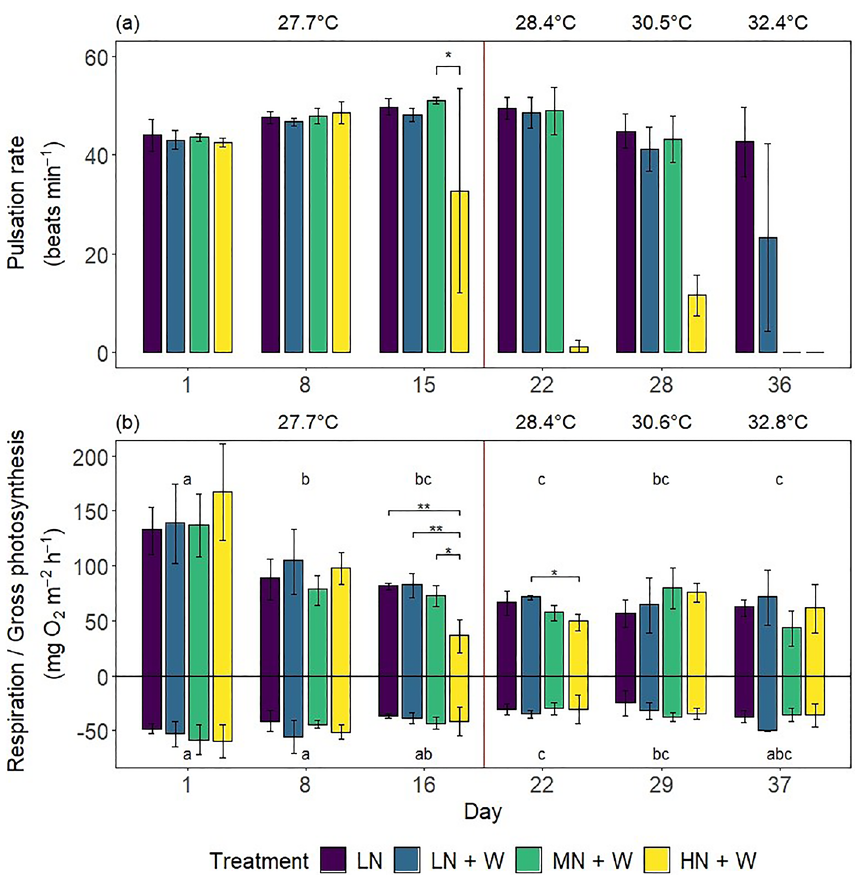
Figure 3. ( a ) Pulsation rates and ( b ) gross photosynthesis (P gross ) and respiration (R) of Xenia umbellata colonies from control tanks with low nitrate (LN, ~ 0.6 μM) and three treatments: LN + W = low nitrate (~ 0.6 μM) + warming from day 17; MN + W = medium nitrate eutrophication (~ 6 μM) + warming from day 17; HN + W = high nitrate eutrophication (~ 37 μM) + warming from day 17. Error bars represent standard deviations of three replicates. Temperatures represent mean temperatures of the respective days, excluding controls. Different letters in ( a ) indicate significant differences between days (pwc, Bonferroni adjustment, t -test, p < 0.05). Asterisks represent significant differences between treatments within days (pwc, Bonferroni adjustment, ( a ) t -test & ( b ) Dunn’s test, ** = p < 0.005, * = p < 0.05).